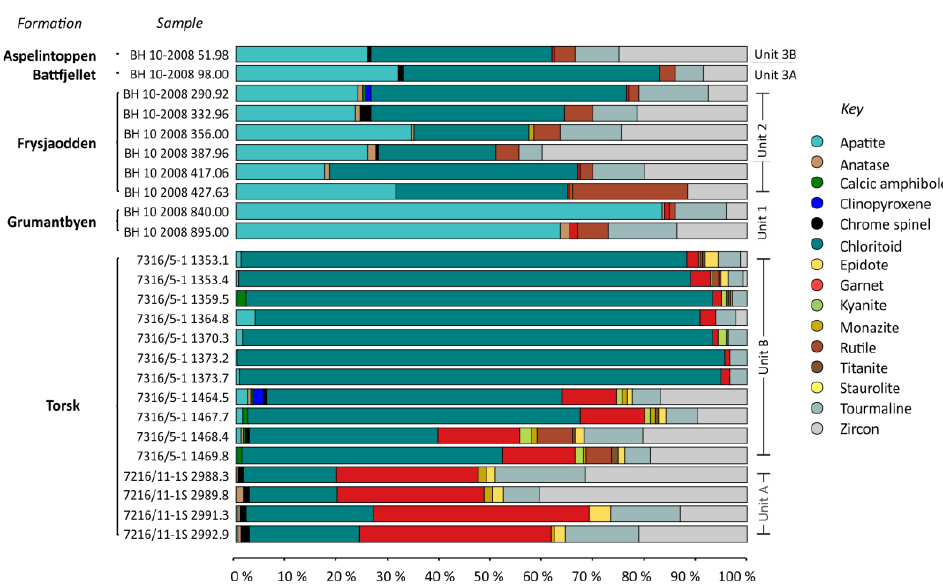
Figure 4. Normalised bar chart showing the non-opaque heavy mineral assemblage of the investi- gated samples. The order of mineral phases shown in the key appear sequentially from left to right in the bar chart.